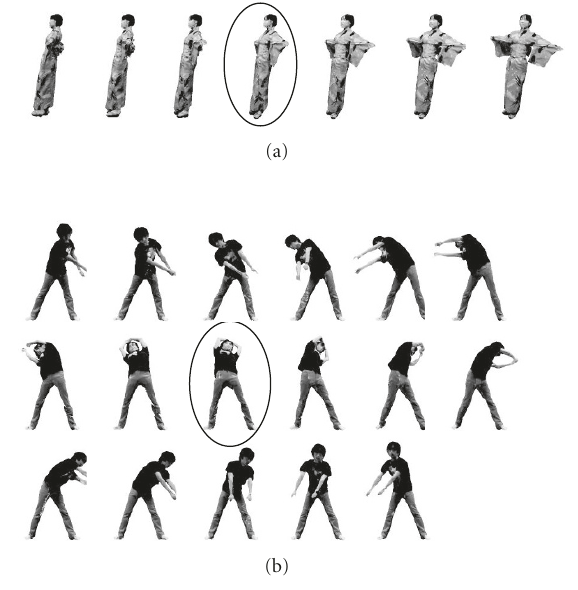
Figure 10: Matrix representing results of similarity evaluation be- tween sequences #2-1 and #2-2. The whiter the color is, the more similar the two clips